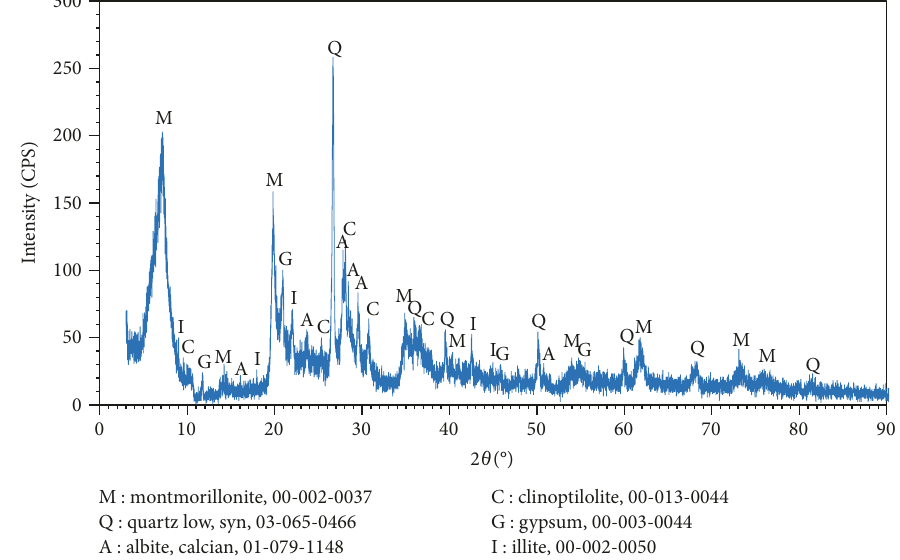
Figure 1: X-ray di ff raction (XRD) of Na-bentonite.